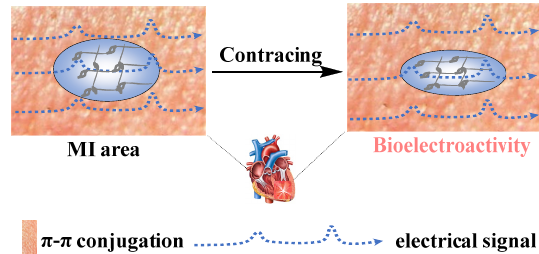
Figure 2. Schematic sketch illustrating the application of this soft and conductive PEG-MEL / HA-SH / GO hydrogel system encapsulating ADSCs for cardiac repair by injection into the MI area of Sprague-Dawley (SD) rats, with the objective of enhancing the transmission of mechanical and electrical signals to rebuild cardiac function. Adapted from [45], Elsevier 2017.